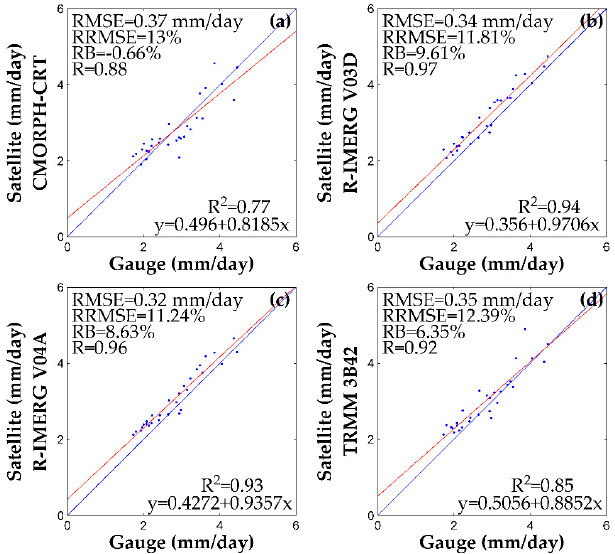
Figure 8. Scatterplots of the four satellite-based estimates versus ground-based rain gauge observations of average daily rainfall for CMORPH-CRT ( a ); R-IMERG V03D ( b ); R-IMERG V04A ( c ); and TRMM 3B42 ( d ) over the Huaihe River Basin between June 2014 and November 2015. The blue and red solid lines denote a 1:1 line and a least-squares regression line, respectively.